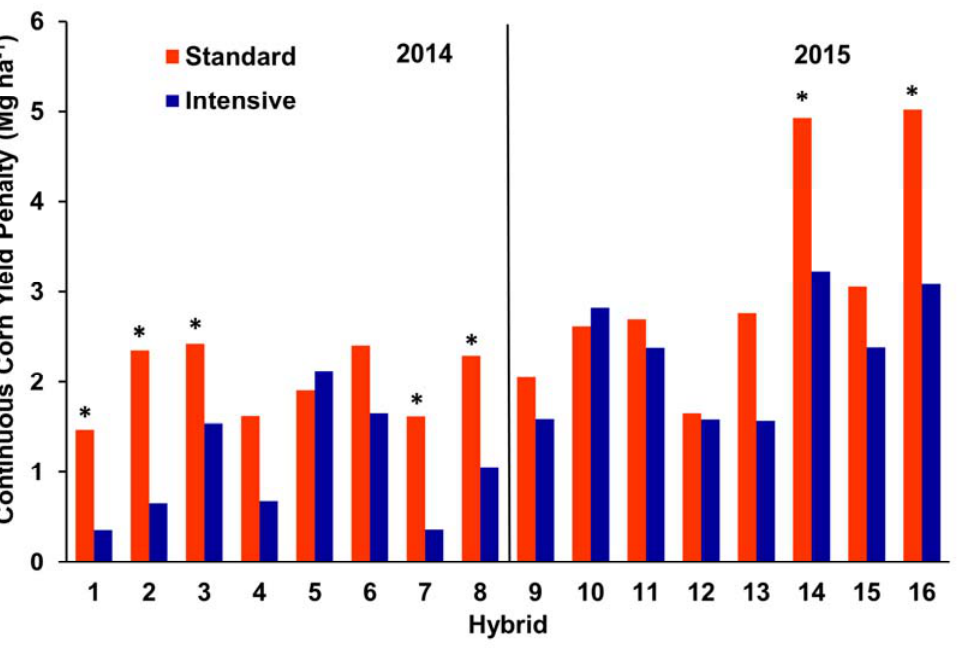
Figure 1. The yield penalty (yield difference between corn-soybean and continuous corn rotation) as influenced by two levels of management (standard vs. intensive) at Champaign, IL during 2014 (hybrids 1–8) and 2015 (hybrids 9–16). Hybrids 1–16 follow the order hybrids were presented in Tables 3–6. Values represent the average of two planting populations. * CCYP (continuous corn yield penalty) significantly different at p ≤ 0.05, due to crop management for each hybrid.